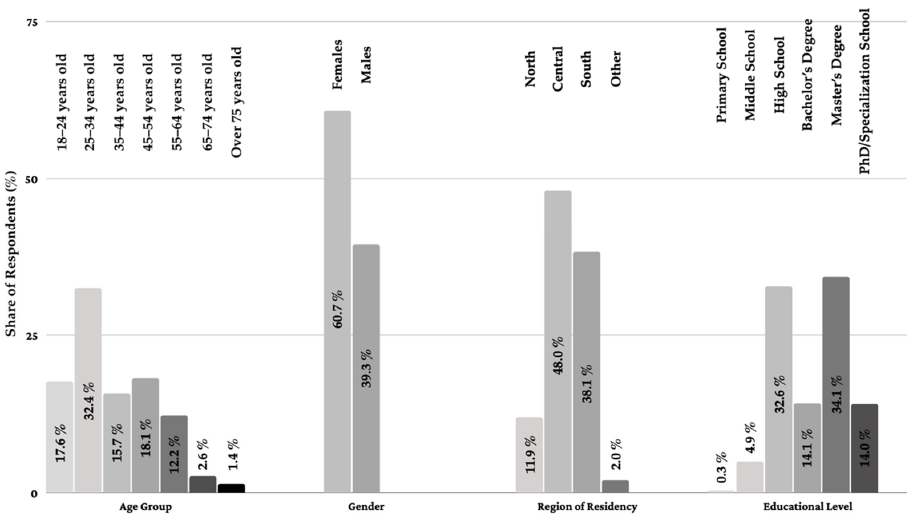
Figure 1. Demographic information of the respondents to the questionnaire ( n = 1003).